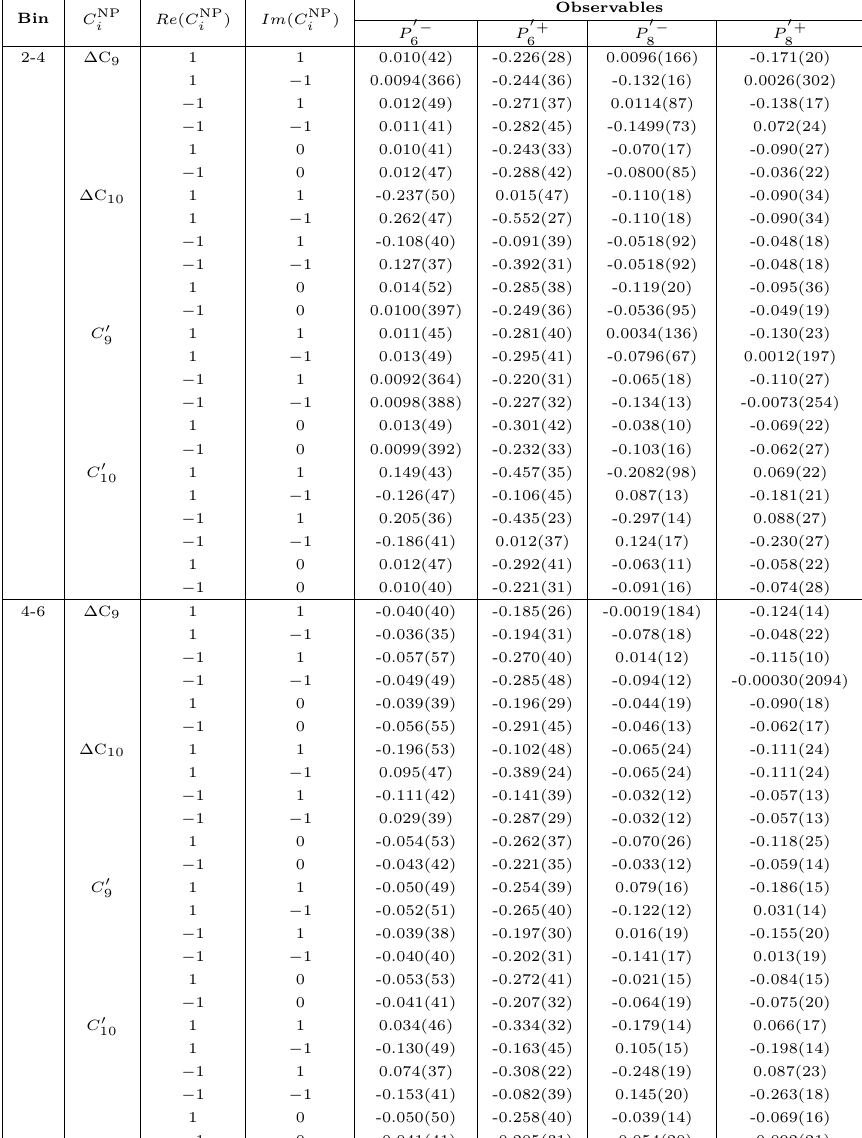
Table 31 . The dependence of some of the optimized observables corresponding to B + → ρ + ll and B − → ρ − ll on the real and imaginary parts of the NP WC’s ∆ C 9 , 10 and C 0 and 4 − 6 GeV 2 for a few benchmark values of the real and imaginary parts of the corresponding